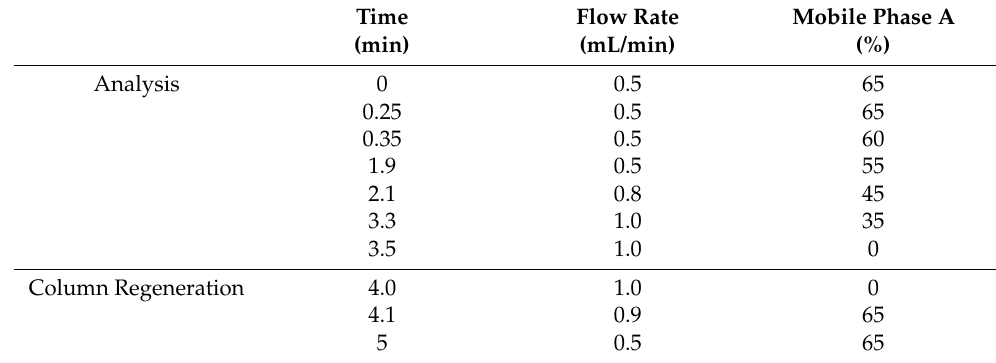
Table 10. LC-gradient conditions for center